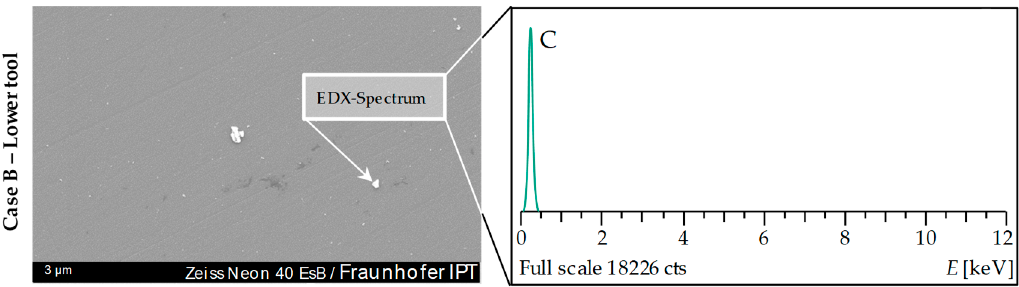
Figure 16. Scanning electron microscope (SEM) inspection of Case B Glassy Carbon moulding tools (after 20 moulding cycles): ( a ) and ( b ) name different measurement spots in the glass contact area.